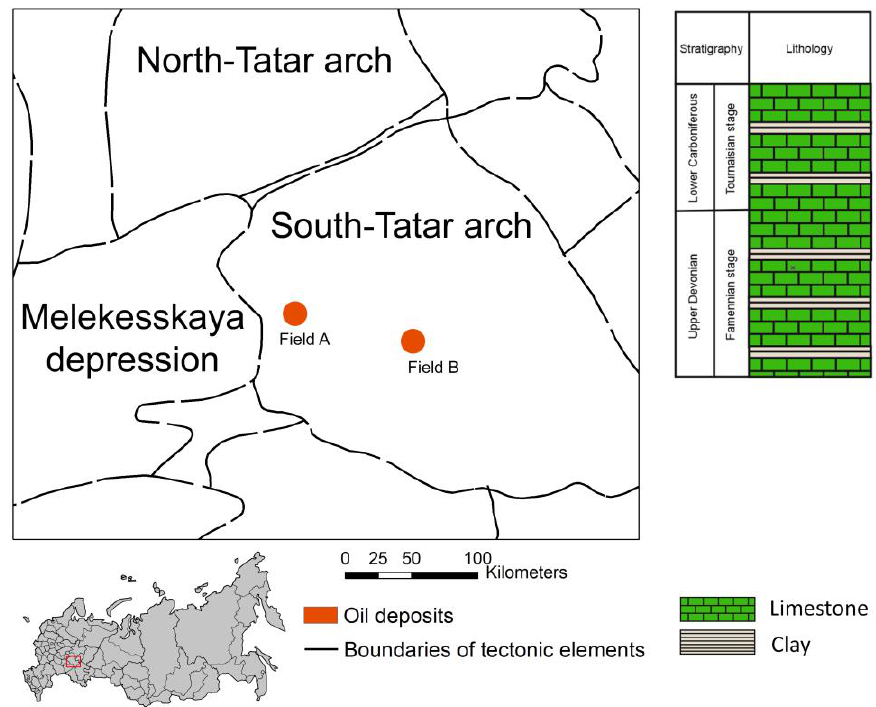
Figure 2. Schematic map of the South Tatar arch of the Volga-Ural basin and part of general geological section.